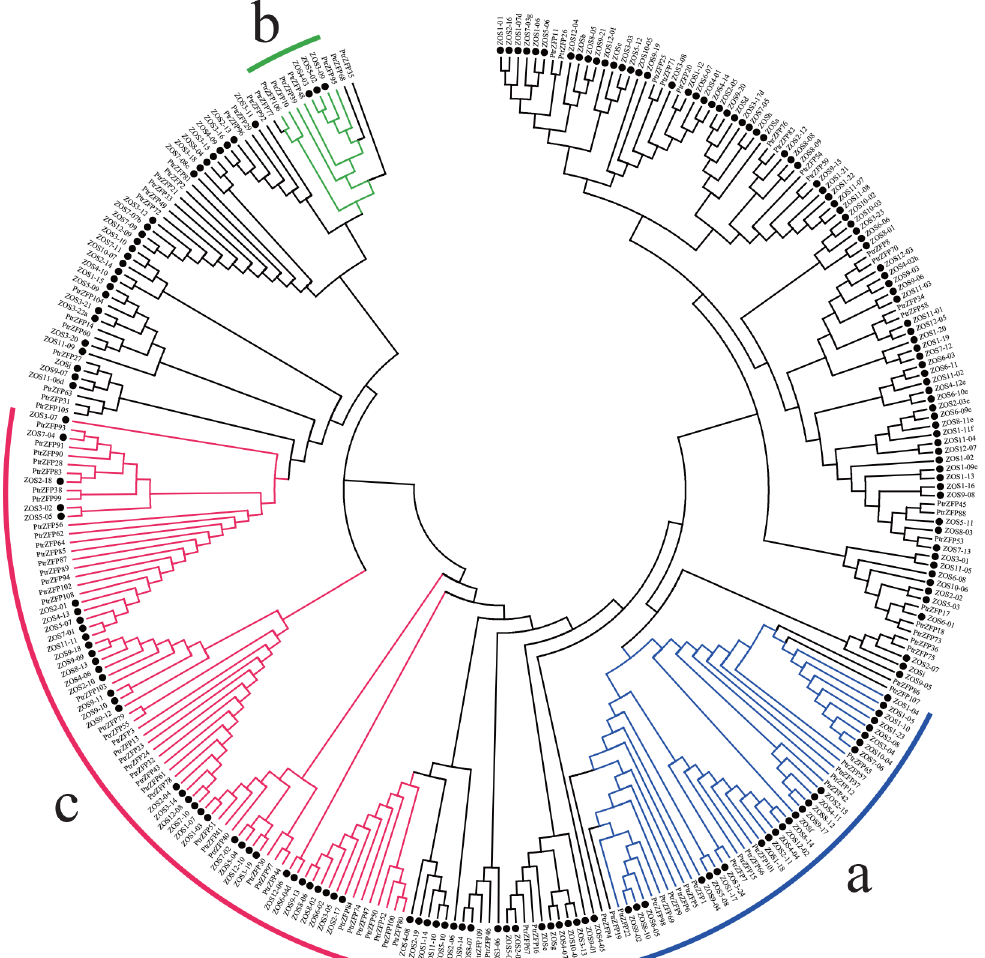
Fig 3. Phylogenetic tree of C2H2-ZF proteins from Populus and rice. One hundred and nine C2H2-ZF proteins in Populus and 189 in rice were aligned using Clustal X 1.83 and the phylogenetic tree was constructed using MEGA 5.0 by the neighbor-joining method. The Bootstrap value was 1,000 replicates. The rice proteins start with Z and are marked with a solid dot to distinguish them from the Populus C2HC2-ZF proteins. The three plant-specific clusters were designated as a, b and c, and indicated in a specific color.